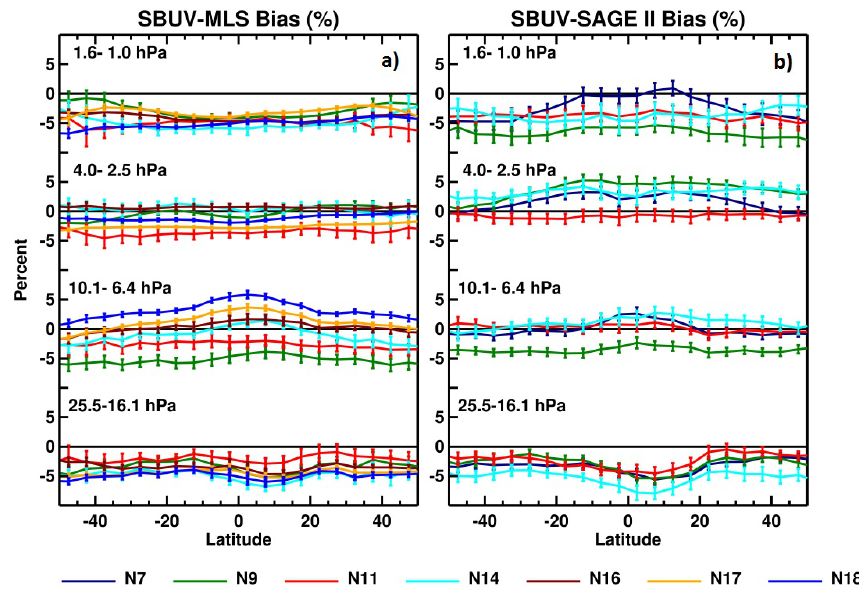
Fig. 4. Mean biases for individual SBUV instruments as a function of latitude for four layers between 25 and 1hPa. Colors correspond to individual SBUV instruments. The vertical bars indicate standard errors of the biases ( σ / and N14 and relative to Aura MLS for N16, N17 and N18. (b) Biases relative to SAGE II data for N7, N9, N11 and